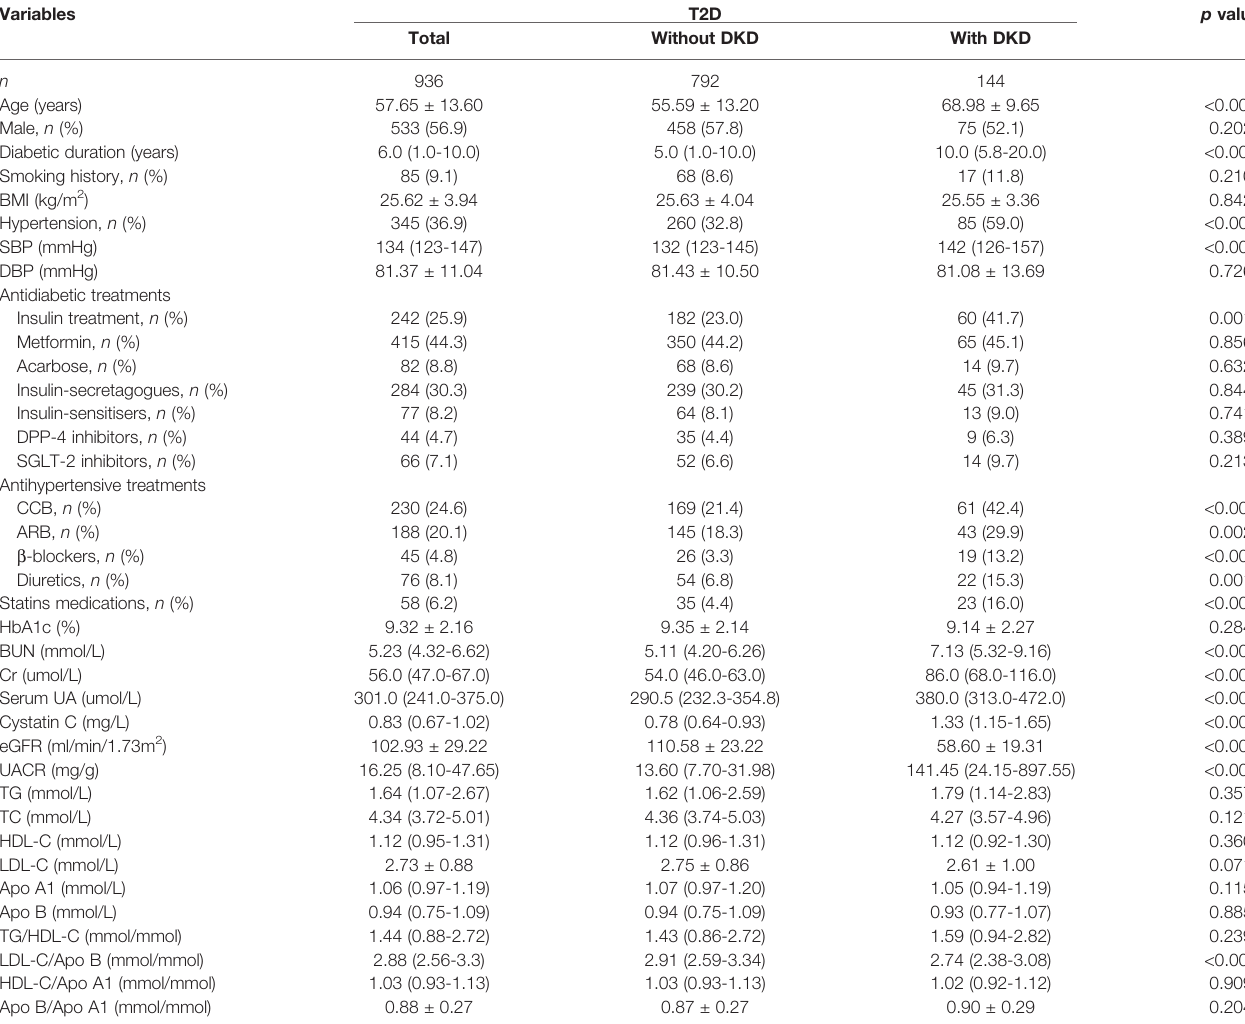
TABLE 1 | Clinical characteristics of the study participants. Variables